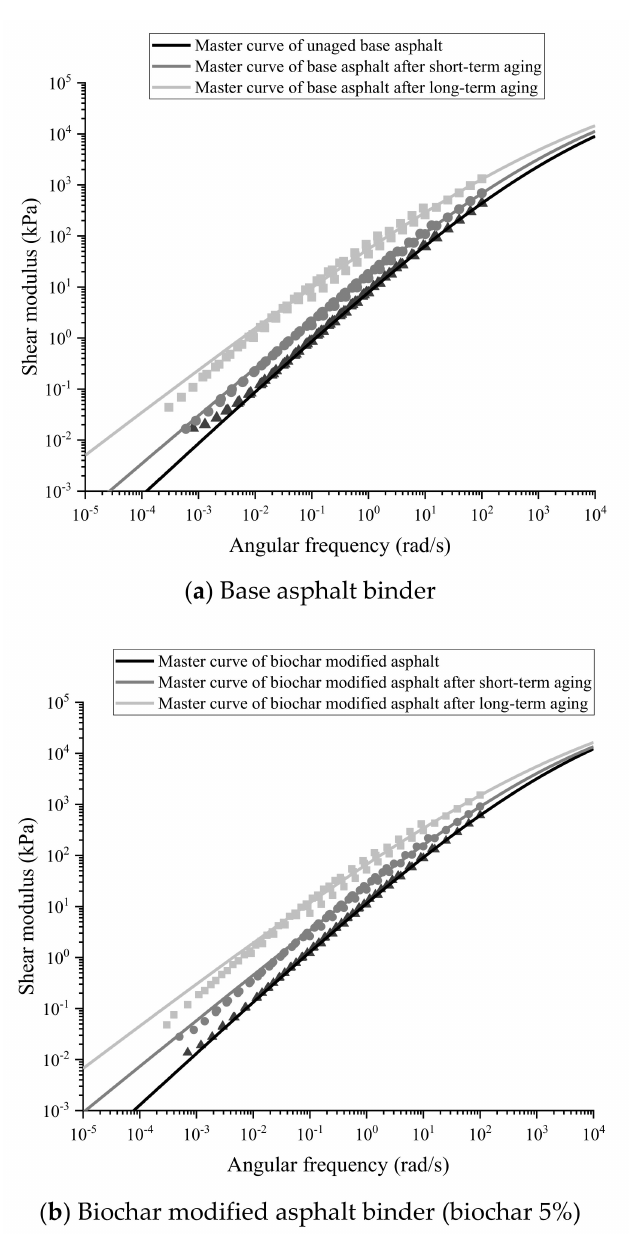
Figure 8. Dynamic shear modulus master curve of asphalt